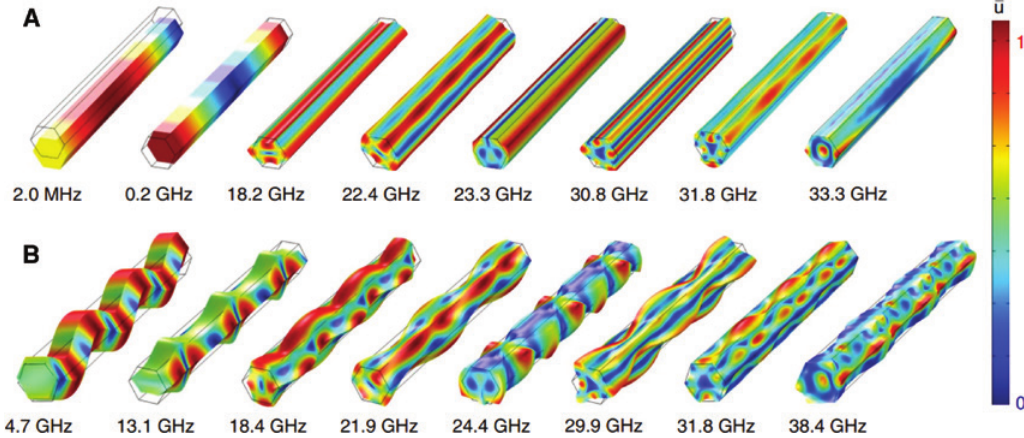
Figure 4: Normalized displacement fields for various modes of a 1 μ m long GaAs nanowire for a wavevector (A) q = 0.3 μ m −1 and (B) q = 18 μ m −1 . The dispersion relations of these modes are displayed in Figure 7. Adapted from [46].